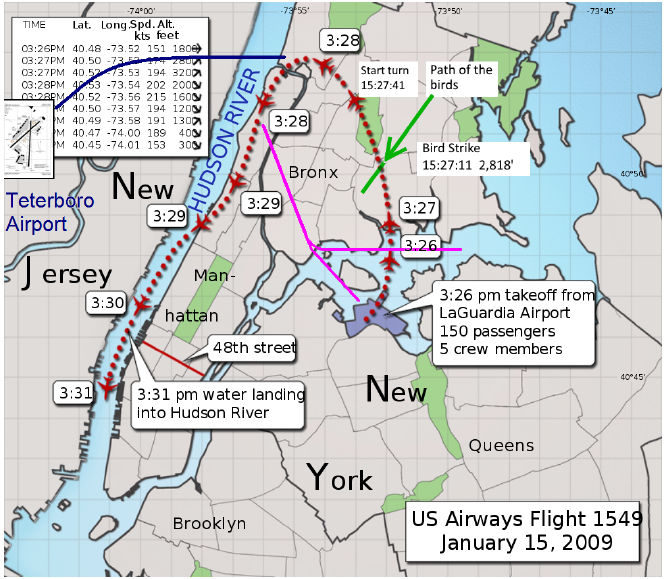
Figure 1. US Airways Flight 1549: Two minutes after takeoff from LaGuardia, the aircraft struck a flock of birds at an altitude of 2818 ft, which caused the loss of engines and forced the pilot to make a sea landing on the Hudson river